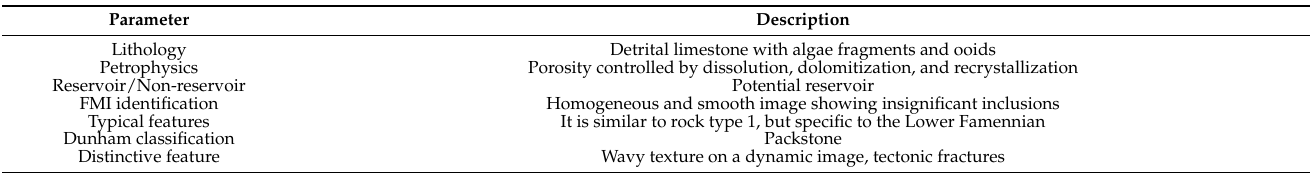
Table 6. Description of main reservoir parameters for RT5.